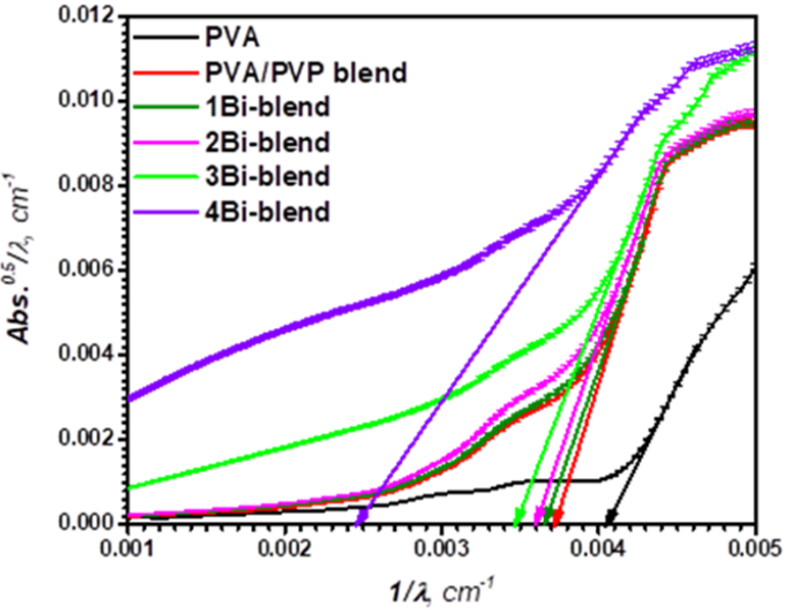
Figure 9. Variation of (Abs/ λ ) 1/2 versus λ − 1 of pristine PVA, PVP/PVA blend, and Bi-blend hybrid films.